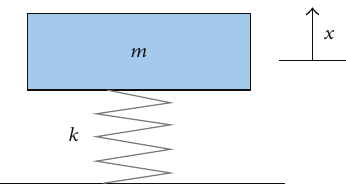
Figure 14: Mass spring system.